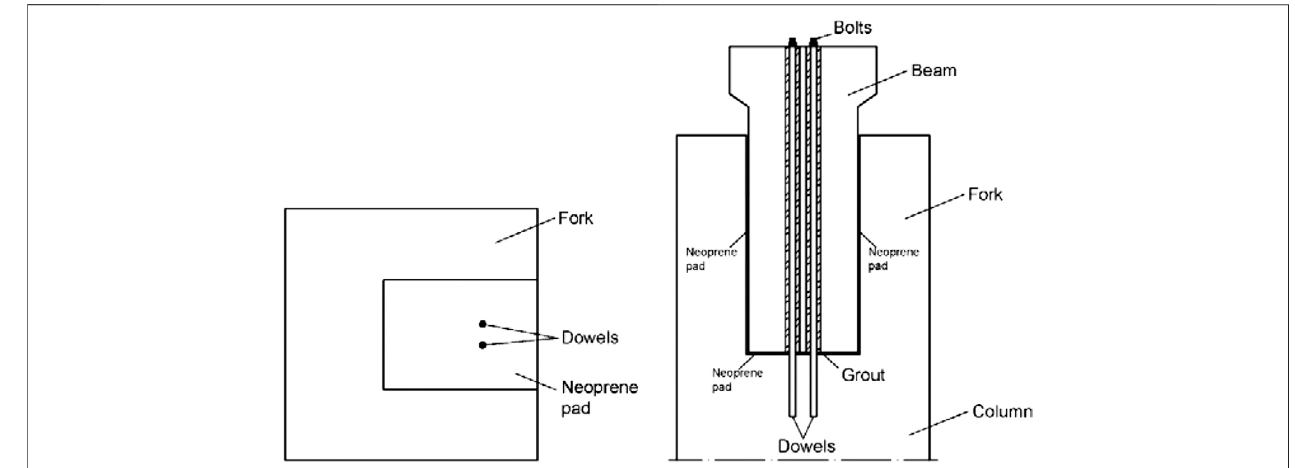
FIGURE 1 | Typical beam-to-column dowel